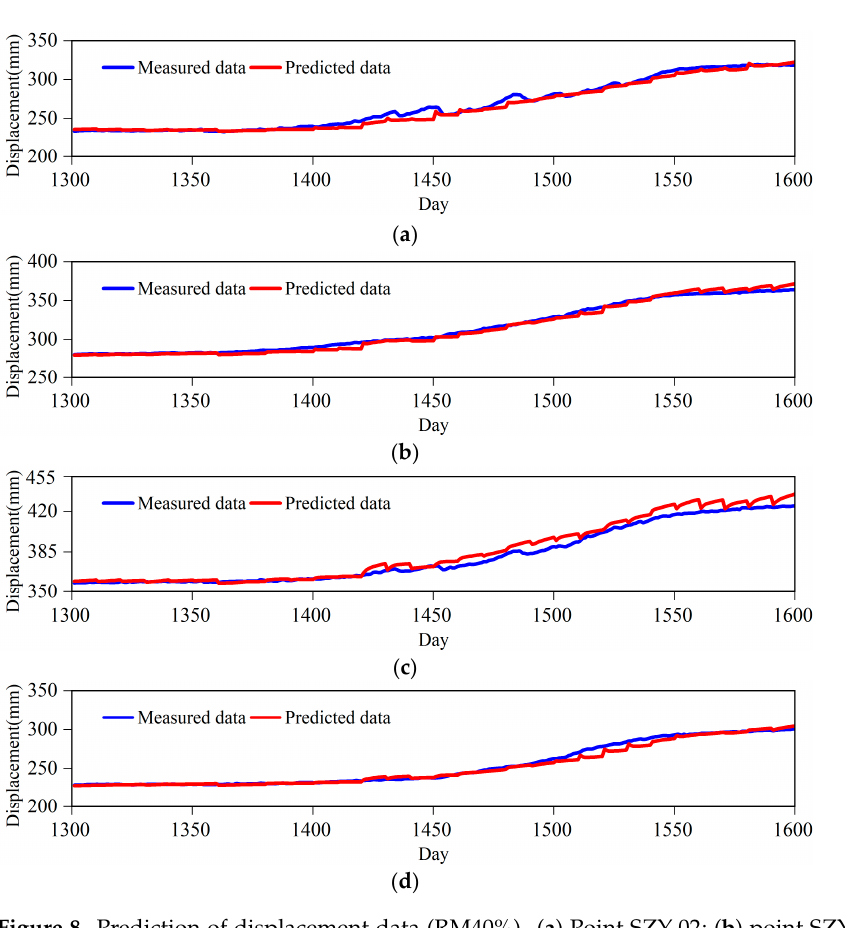
Figure 7. Completion of displacement data (RM40%). ( a ) Point SZY-02; ( b ) point SZY-03; ( c ) point SZY-06. The blue curve represents the measured data, the yellow dots represent the missing data and the red curve represents the recovered data.